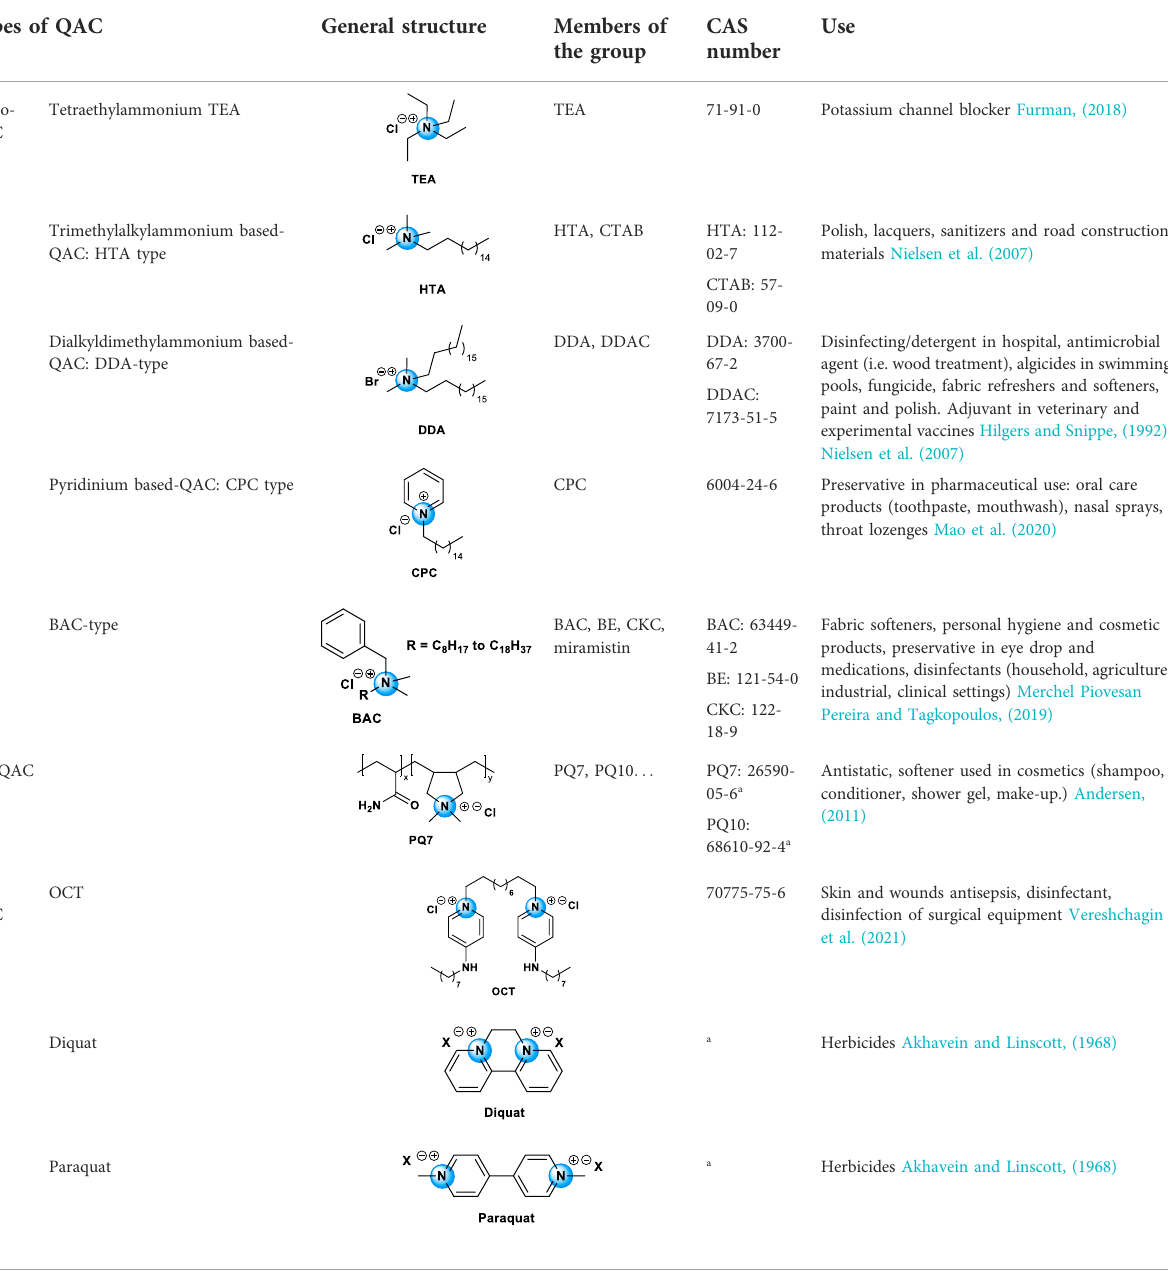
TABLE 1 Classi fi cation of quaternary ammonium compounds and their main